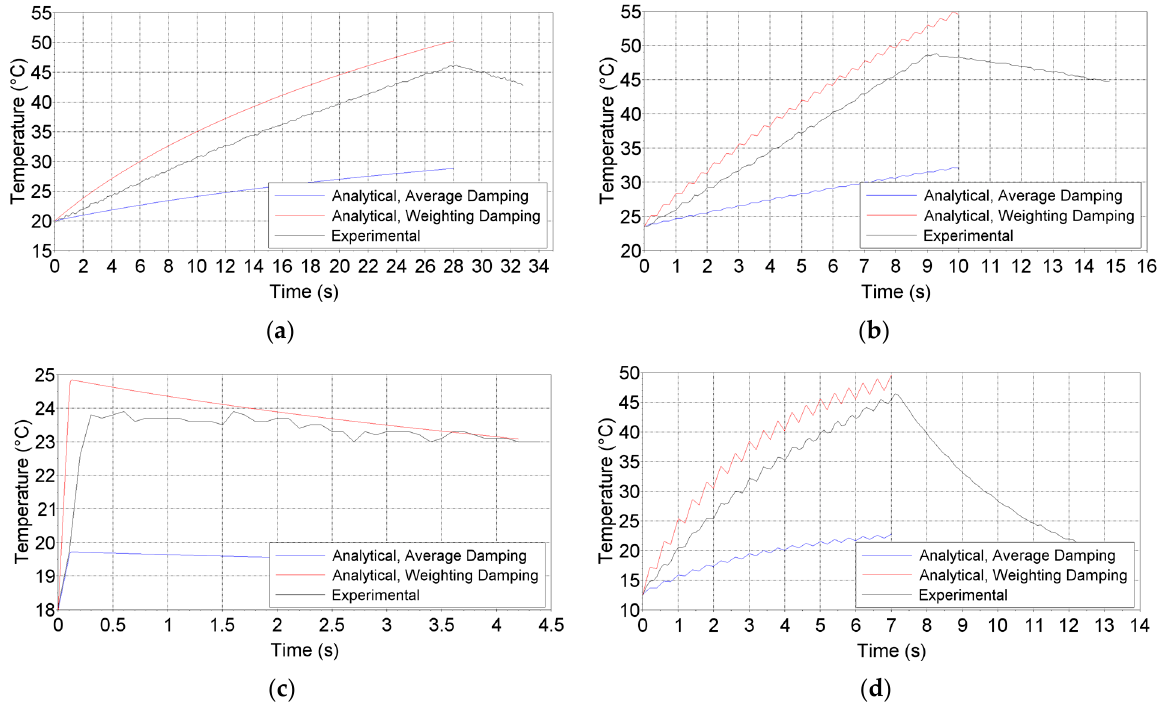
Figure 21. Experimental and computational model temperature comparison, 316L D6 stainless steel, UHCF specimen: ( a ) Maximum stress = 100 MPa, continuous excitation; ( b ) Maximum stress = 150 MPa, t on = 0.2 s, t off = 0.2 s, 23 pulses; ( c ) Maximum stress = 250 MPa, t on = 0.11 s, t off = 5 s, 1 pulse; ( d ) Maximum stress = 200 MPa, t on = 0.2 s, t off = 0.2 s, forced convection, h = 1500 W/(m 2 .K), 18 pulses.